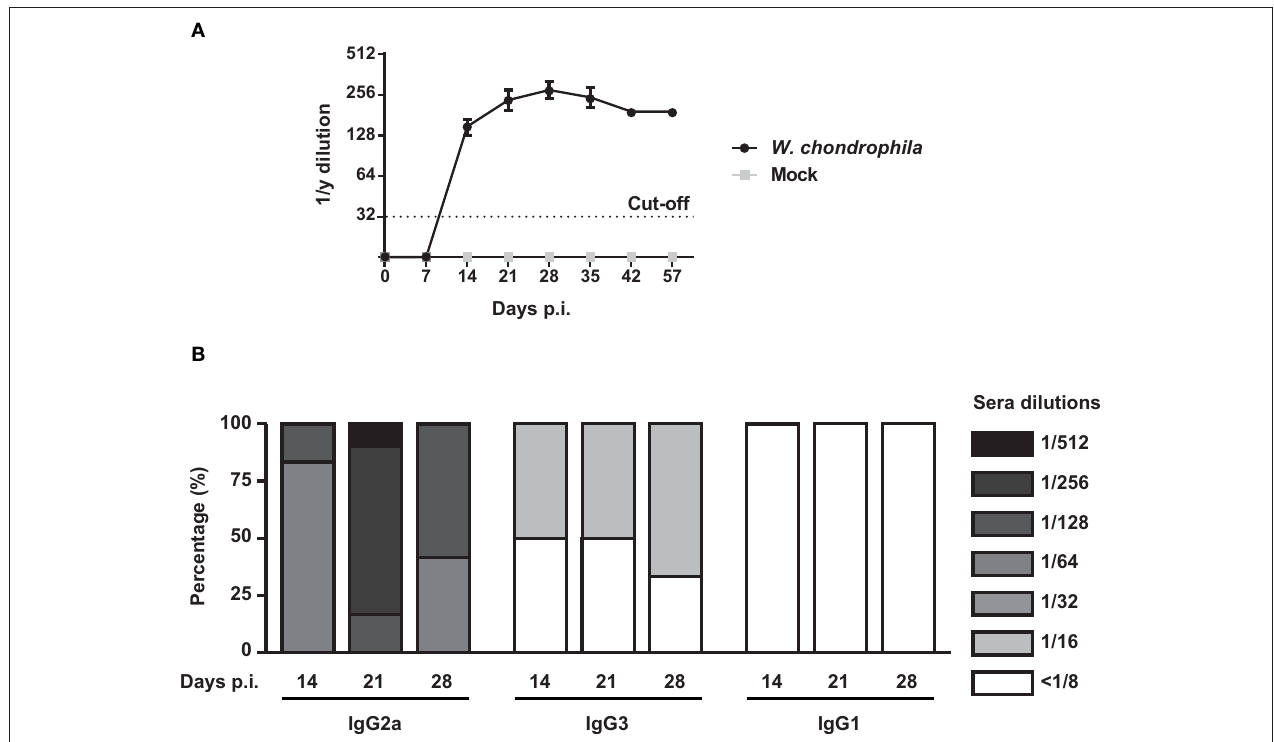
FIGURE 5 | IgG response and detection of IgG isotpyes from sera in W. chondrophila infected mice. Mice were infected with 10 9 W. chondrophila or mock. (A) IgG titers from sera were measured by MIF on days 0, 7, 14, 21, 28, 35, 43, 57 p.i. (B) Comparison of MIF IgG2a, IgG3, and IgG1 from infected mice on days 7, 14, 21, 28, 35 p.i. Data are representative of 12 individual